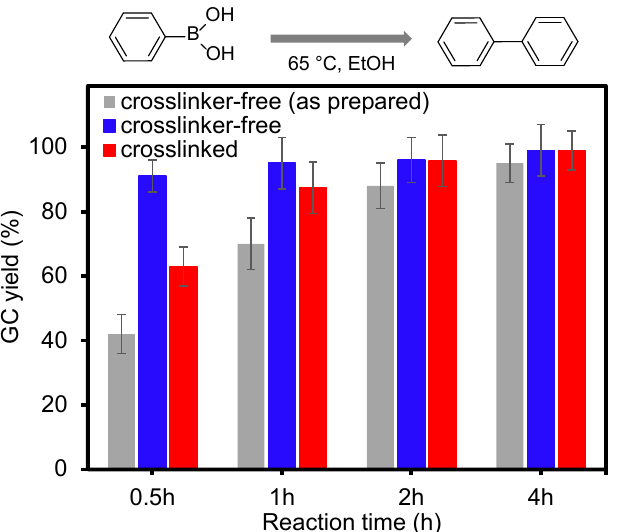
Figure 4. Homocoupling reaction yields (%) using both composite particles as a function of time [note: crosslinker-free (as prepared) indicates that the composite particles contain the fewer number of AuNPs across the crosslinker-free PNIPAM particles].